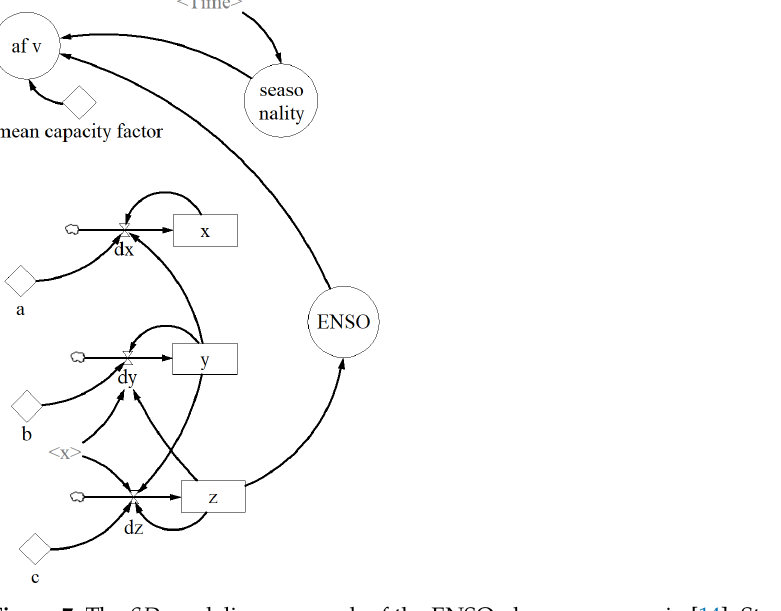
Figure 7. The SD modeling approach of the ENSO phenomenon as in [14]. Stock-flow structure of the af v . Note that af v is the same variable of Figure 5 called (V) Availability factor. This variable connects the ENSO phenomenon with the electricity